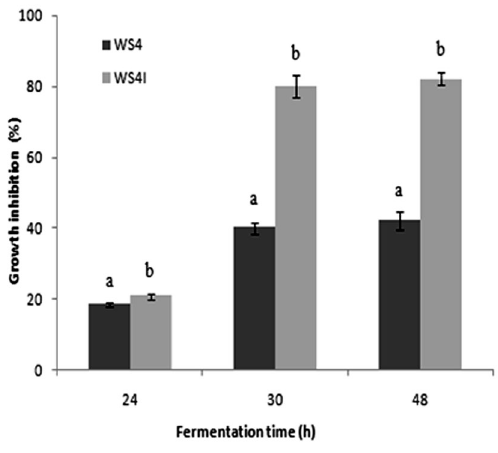
Figure 7. Effect of the production medium on P. temperata K122 oral toxicity. Letters ( a , b ) above each column indicate significant differences among oral toxicity of the strain K122, cultured in WS4 and WS 4 I at p <